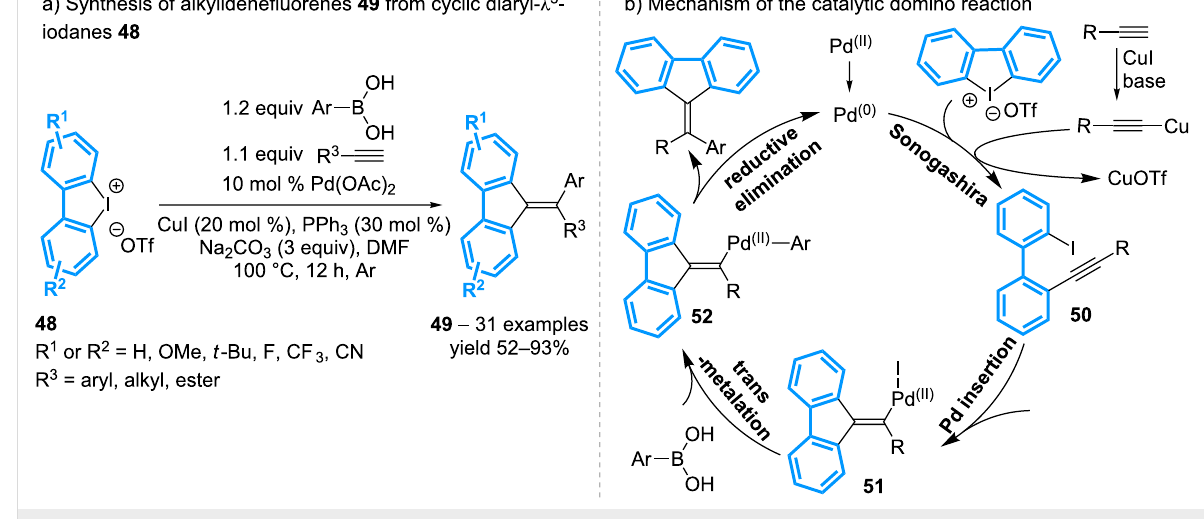
Scheme 17: Synthesis of alkylidenefluorenes from cyclic diaryl- λ 3 -iodanes.